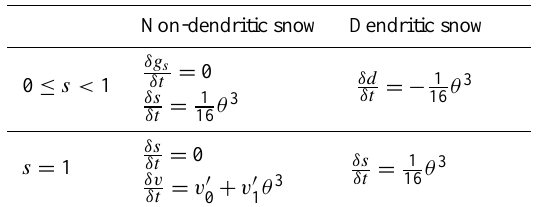
Table 2. Empirical laws for wet snow metamorphism. θ is the mass liquid water content and t is time expressed in days. v refers to the equivalent volume of snow grain and v 0 constants taken from Brun (1989). Note that θ can be computed from the prognostic variables of the snowpack scheme Crocus as W liq θ = 100 ρD